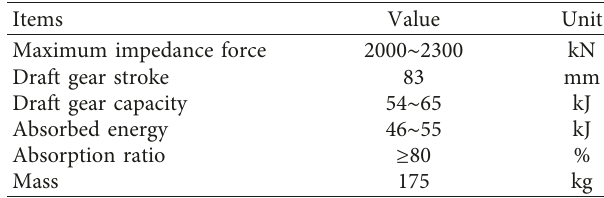
Table 1: The main parameters of MT-2 draft